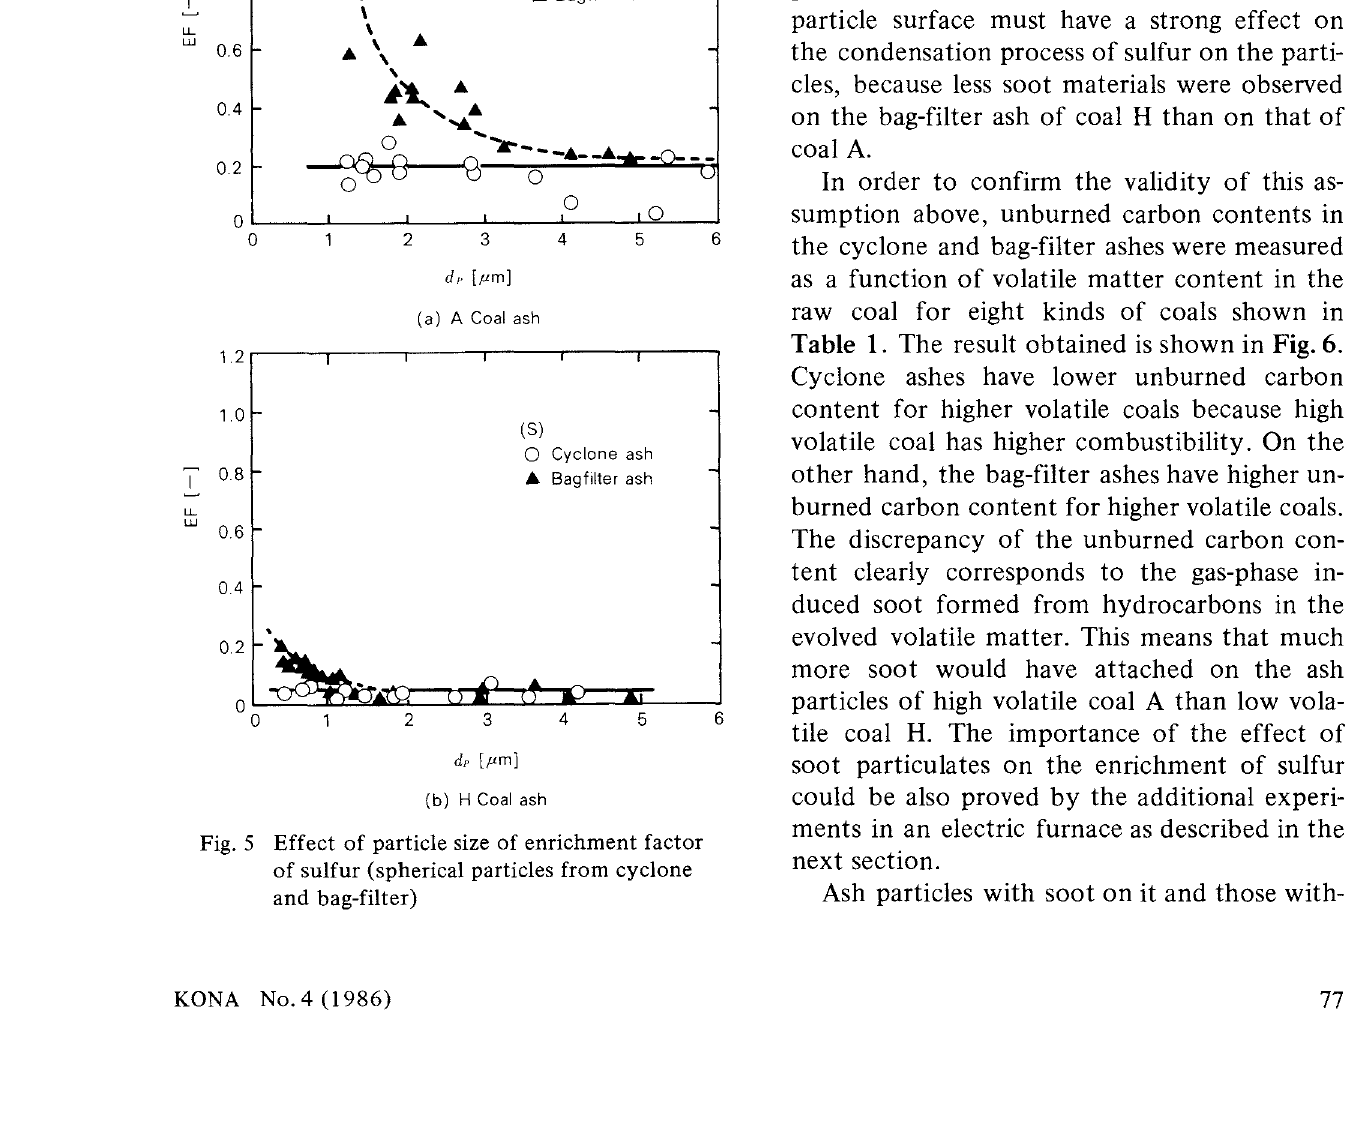
Fig. 4 Enrichment factors of sulfur on various